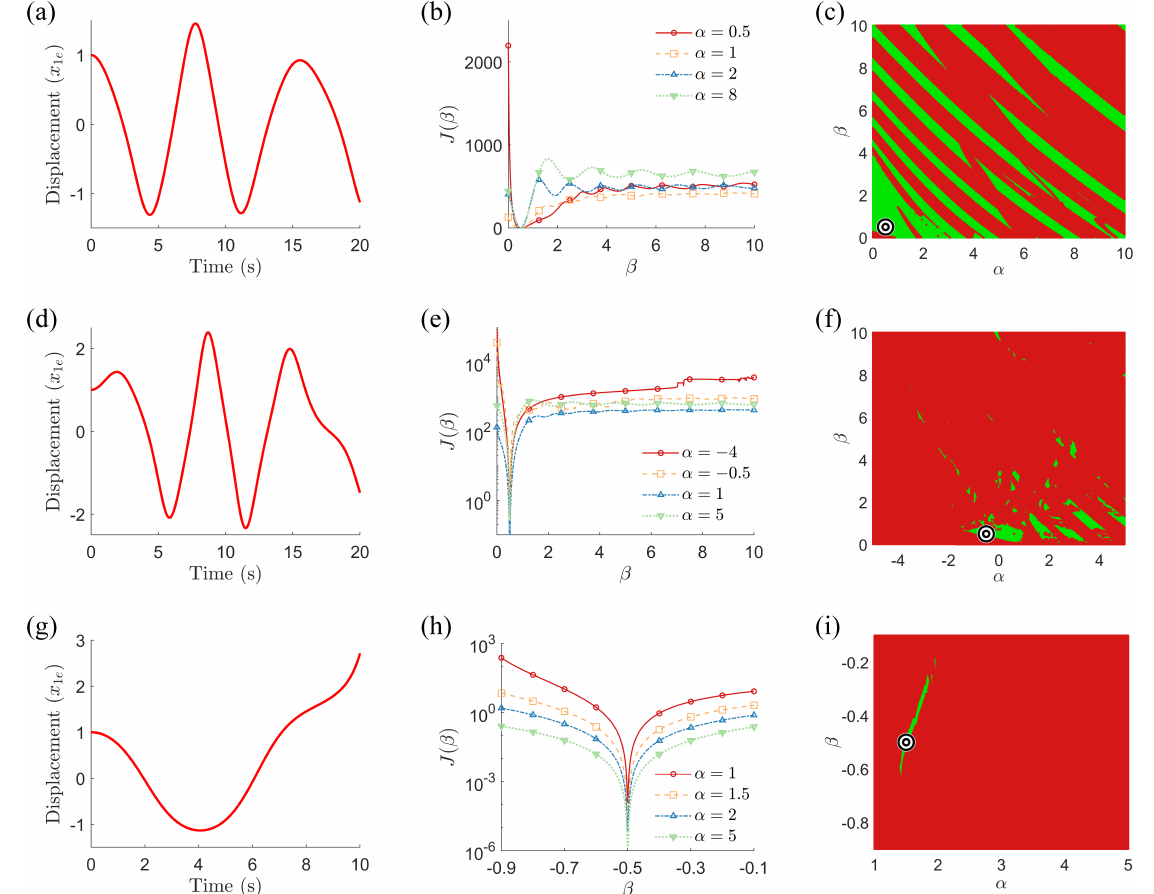
Figure 1. Parameter identification problem description for three van der Pol–Duffing oscillators: ( a – c ) single-well, ( d – f ) double-well, and ( g – i ) double-hump. ( a , d , g ): experimental data used for parameter identification ( x 1 e ( t ) ); ( b , e , h ): shape of objective function over β ( J ( β ) ) for four values of α and with µ = 0.1; ( c , f , i ): basins of attraction with µ = 0.1. In panels ( c , f , i ), initial parameter guesses in the dark-red regions lead to local minima when a simple gradient-based optimizer is used; points in the light-green regions lead to the global minimum, indicated with a “target”